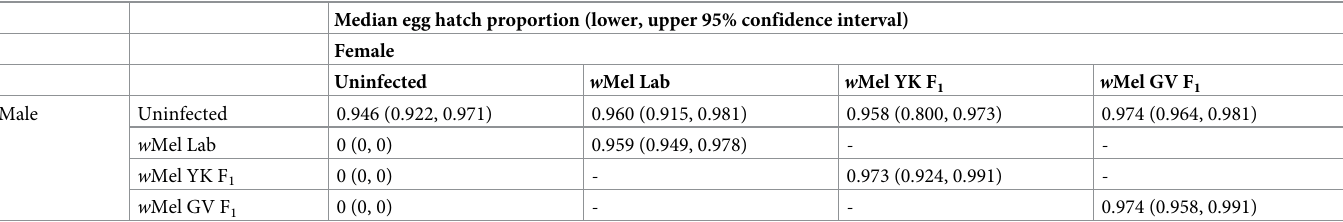
Table 1. Reciprocal crosses between w Mel-infected Aedes aegypti from laboratory or field origins and uninfected Ae . aegypti . Crosses with “-”were not